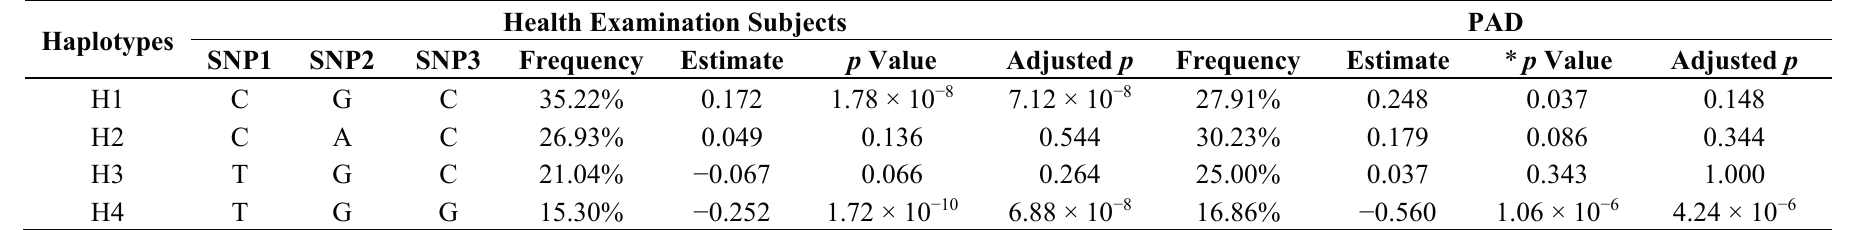
Table 6. Association of CHI3L1 locus haplotypes with YKL-40